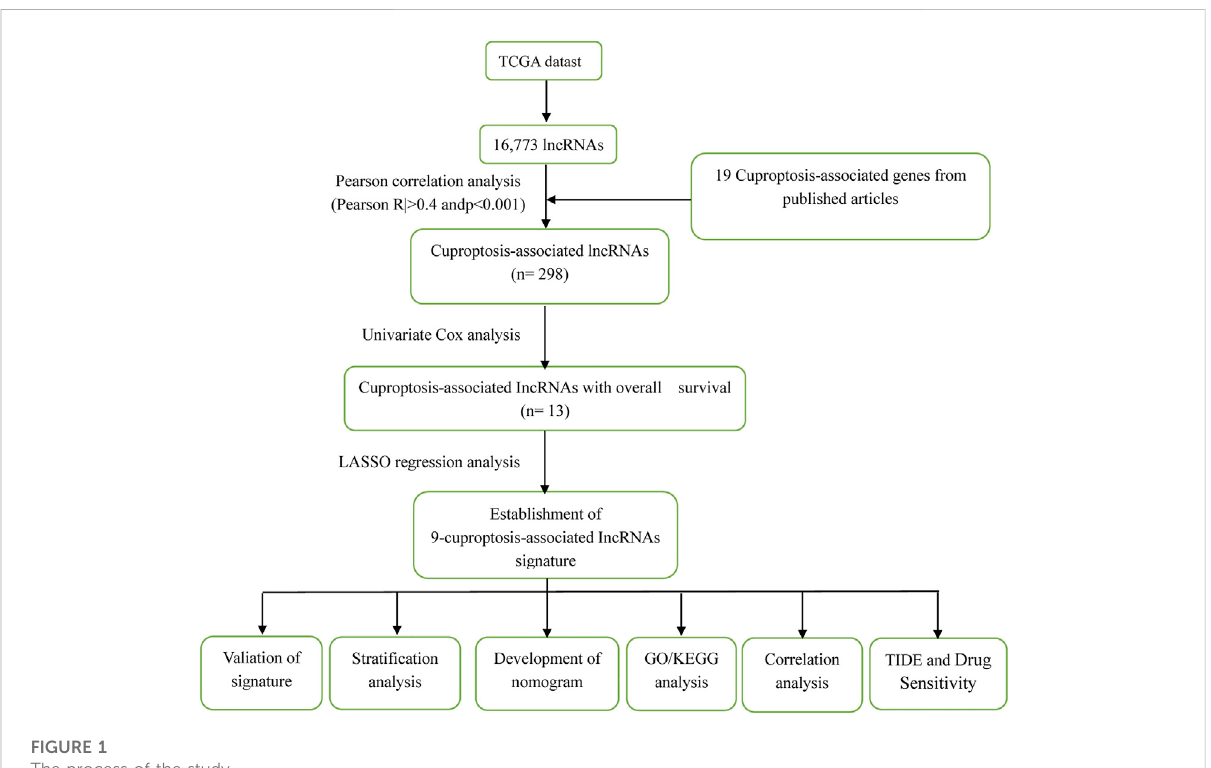
FIGURE 1 The process of the